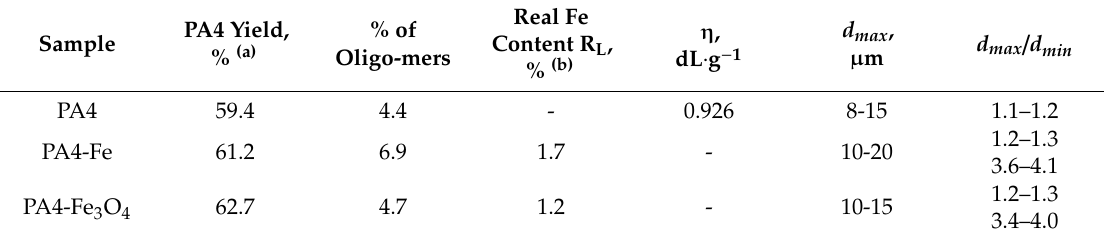
Table 1. Designation and some characteristics of the PA4 MP empty